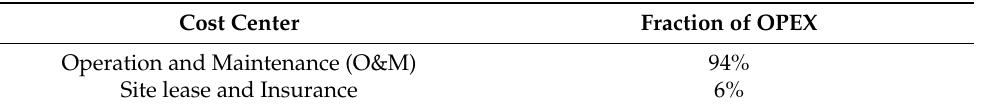
Table 1. OPEX breakdown of